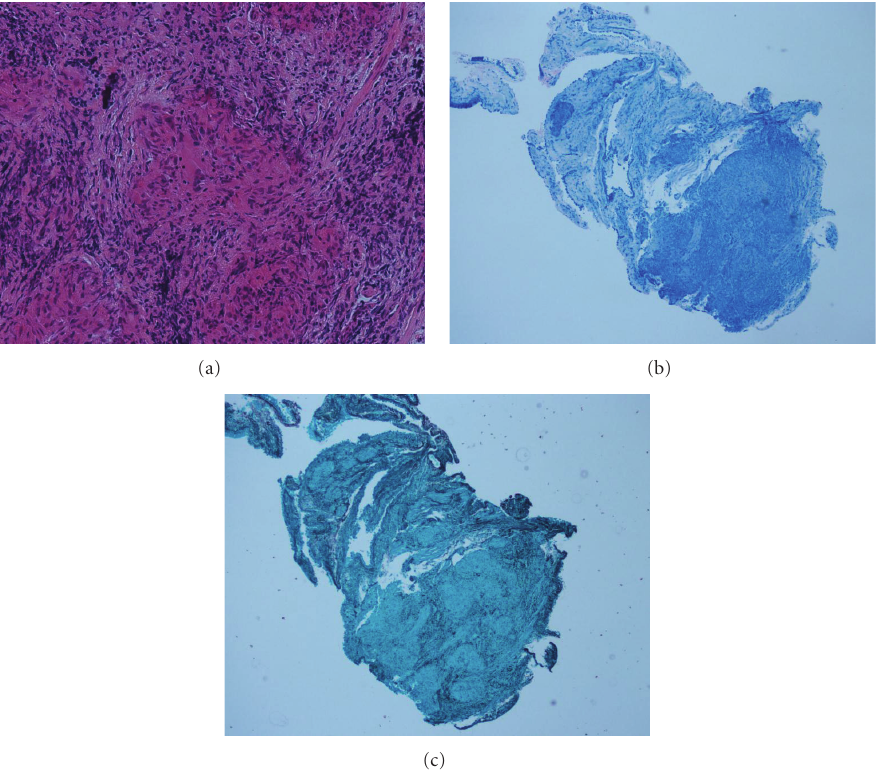
Figure 3: Histological analysis of transbronchial biopsies. (a) H&E stain showing presence of noncaseating granuloma with surrounding lymphocytes. (b) Ziehl-Nielson—no acid fast bacilli seen. (c) Grocott Stain—no fungal elements